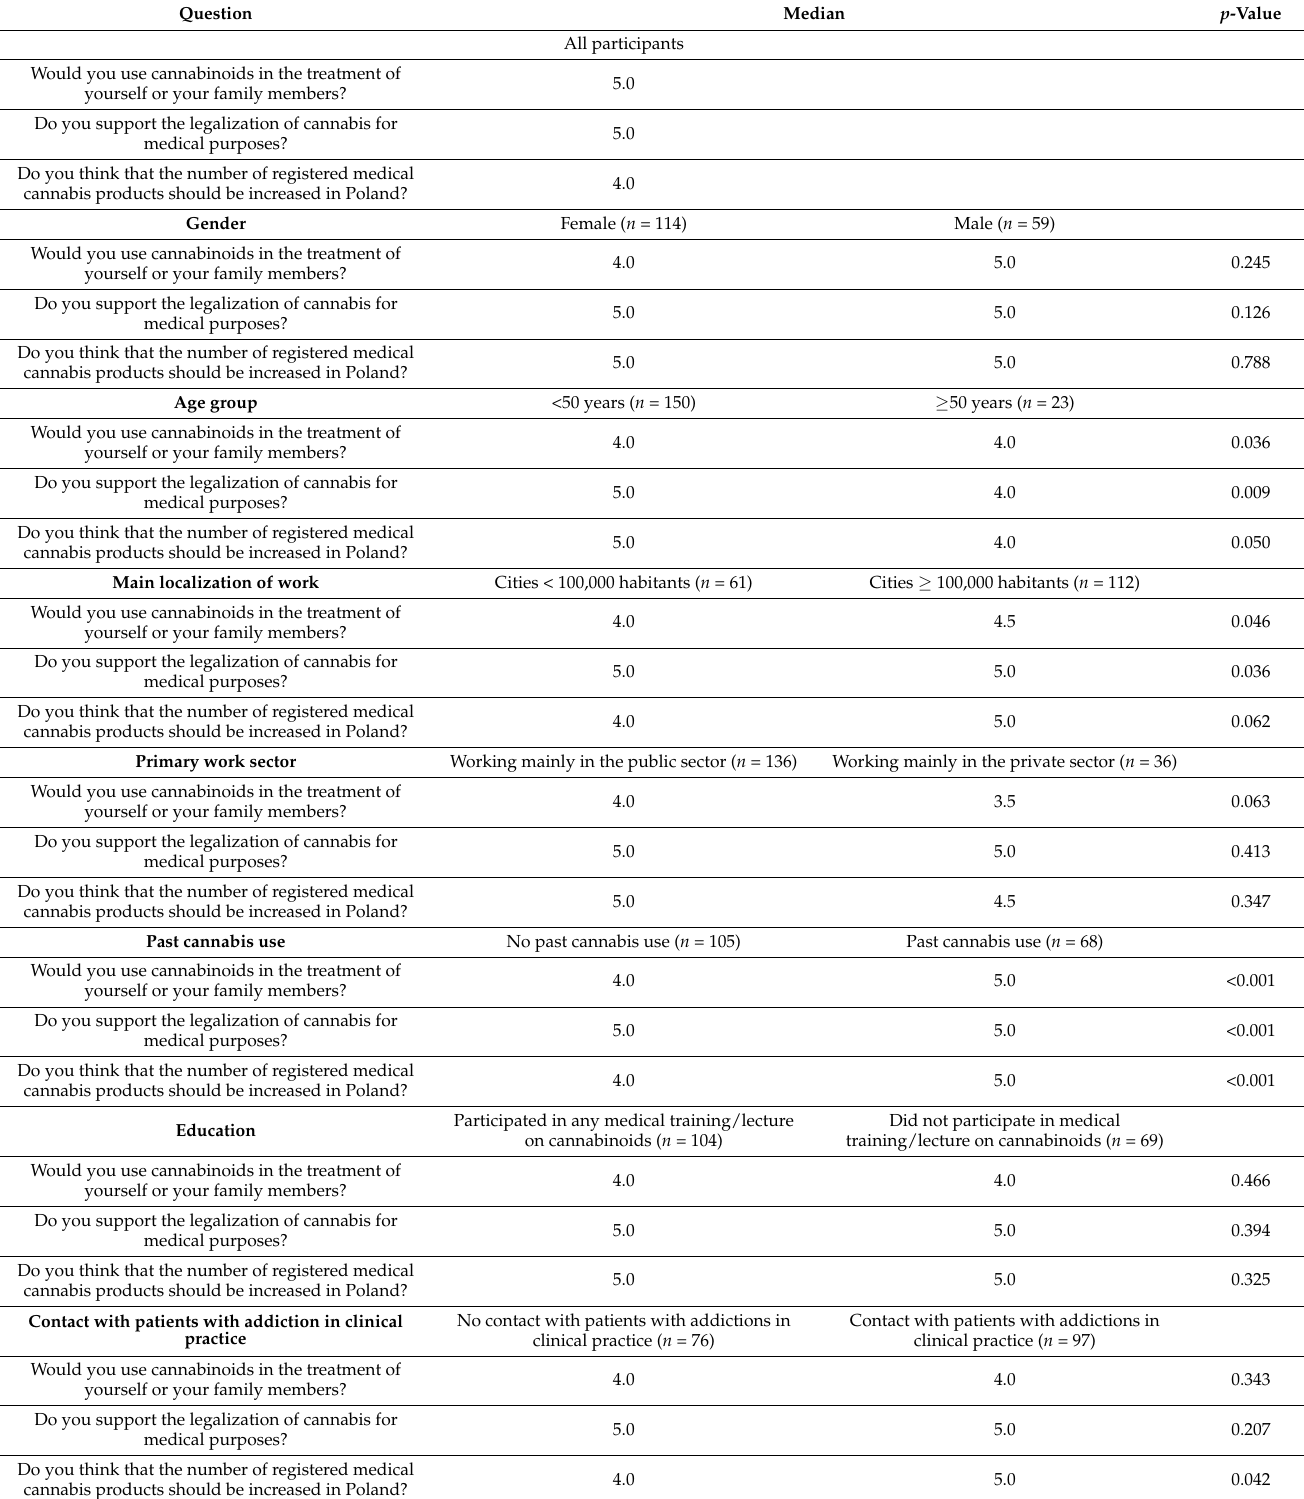
Table 6. Factors linked with support for cannabis use in clinical practice and its